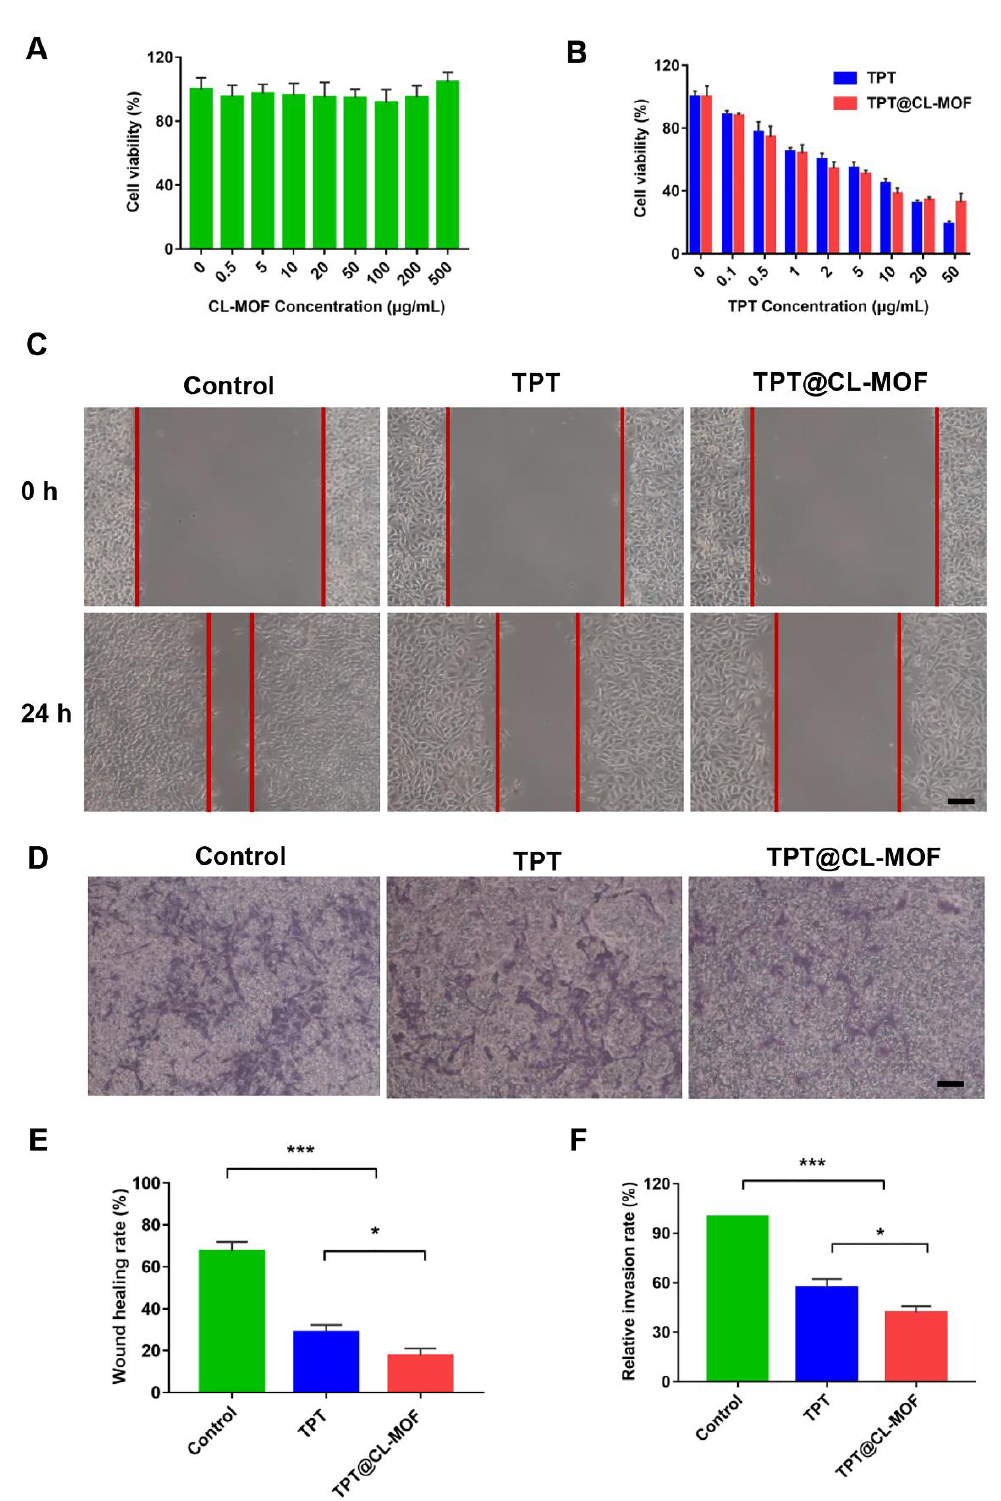
Figure 3. In vitro inhibitory effects of TPT and TPT@CL-MOF on the B16F10 cells. ( A ) The cytotoxicity of CL-MOF in melanoma cells ( n = 6). ( B ) Cell viability of TPT and TPT@CL-MOF treated B16F10 melanoma cells ( n = 6). Images ( C ) and Wound healing rates ( E ) of B16F10 melanoma cells ( n = 3). The distance between the two red lines in ( C ) is the wound healing distance. Invasion images ( D ) and Invasion rates ( F ) of B16F10 melanoma cells ( n = 3). Scale bars, 100 μm. * p < 0.05, *** p < 0.001.